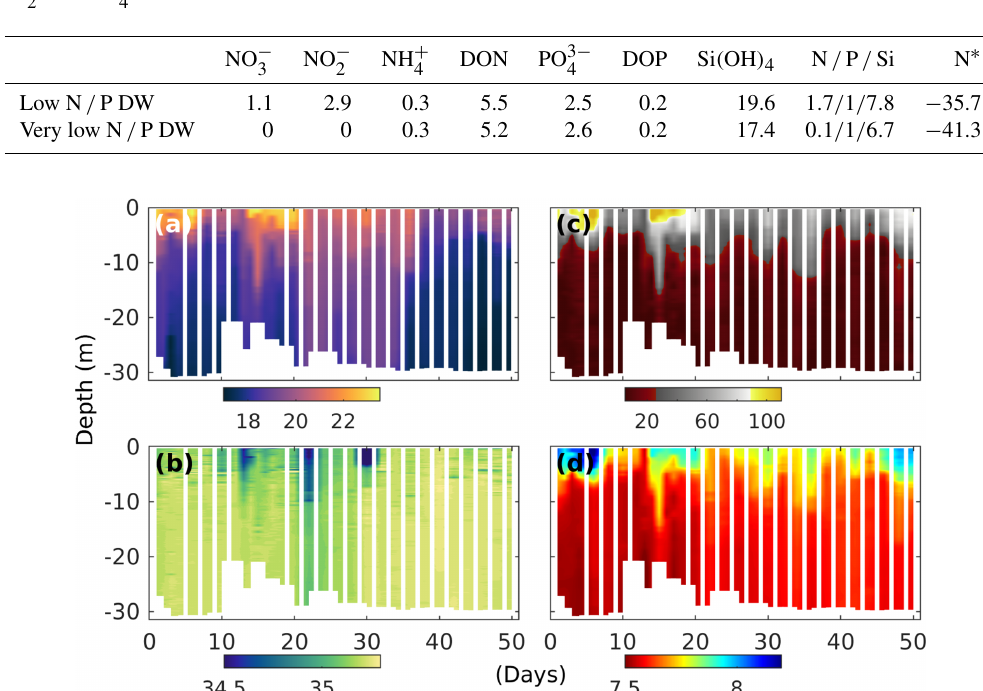
, with DIN denoting the 4